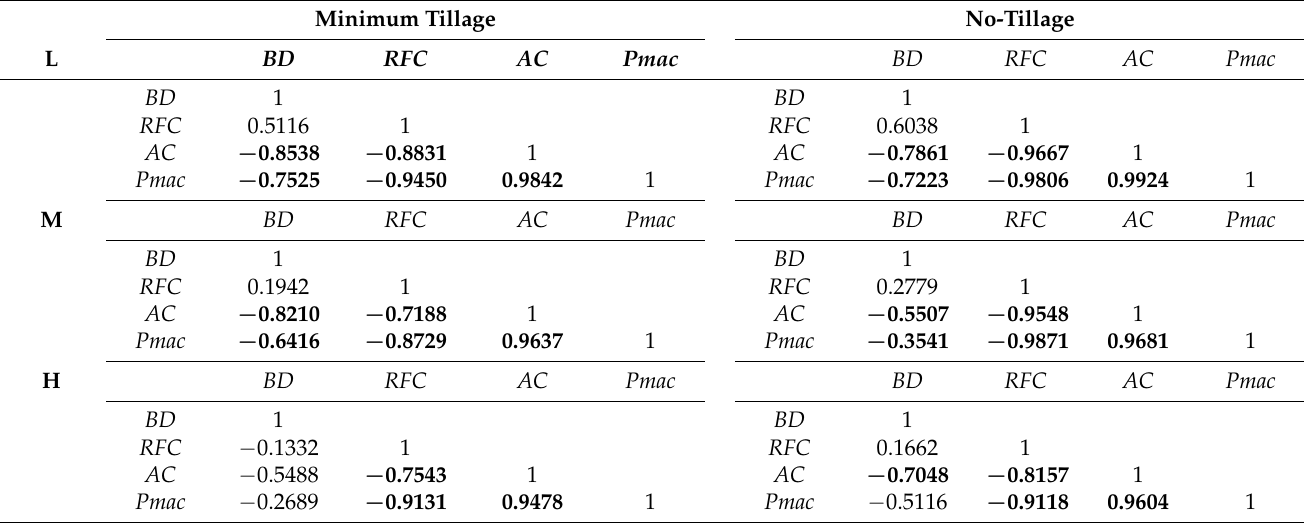
Table 2. Matrix of linear correlation between soil bulk density ( BD ) and capacitive indicators obtained by BEST-steady (relative field capacity, RFC , air capacity, AC , macroporosity, Pmac ), under low (L), intermediate (M) and high (H) heights of water pouring. Significant correlations were highlighted in